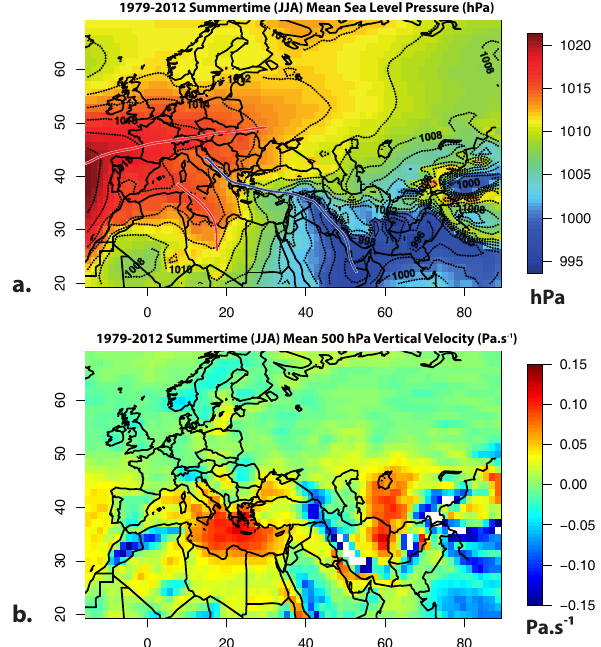
Figure 1. 1979–2012 summertime (June, July and August) averages of meteorological variables taken from 12h ERA-Interim reanaly- sis: (a) sea level pressure (hPa) (colour shading and black contour lines) – the red lines represent the high-pressure ridges and the blue line the deep trough; (b) 500hPa vertical velocity (Pas − 1 ) (white colour corresponds to out-of-range